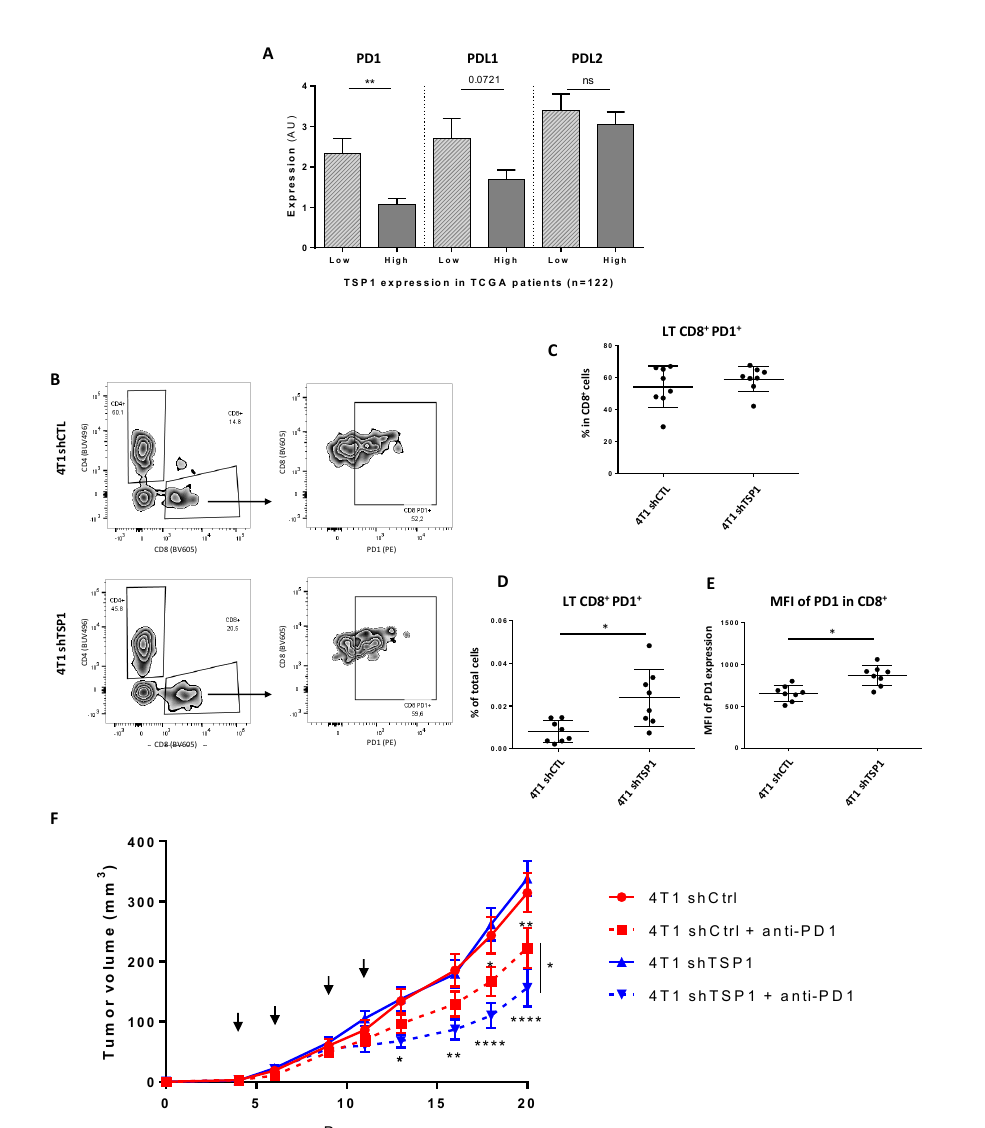
Figure 5. Impact of TSP1 expression on PD-1 expression and anti-PD-1 treatment in 4T1 mouse breast cancer model. ( A ) Analysis of PD-1, PD-L1 and PD-L2 expression in TCGA patients was performed depending on the median expression of TSP1 (**: p < 0.01). ( B – E ) At day 11, PD-1 expression on CD8+ TILs was quantified by flow cytometry on 4T1 shCTL and 4T1 shTSP1 tumors from Balb-c mice (*: p < 0.05) ( B ). Proportion of PD-1+ cells among CD8+ TILs ( C ) or total cells ( D ). Mean fluorescence intensity (MFI) of PD-1 expression on CD8+ TILs ( E ). ( F ): 1 × 10 5 4T1 shCTL or 4T1 shTSP1 breast carcinoma cells were orthotopically injected into the mammary fat pad of WT Balb/c mice. Mice received four injections of anti-PD-1 antibodies at days 4, 6, 9 and 11 (black arrows) at 10 mg/kg. Alternatively, mice were injected with isotype control. Tumor volumes were determined with a caliper at the indicated days. Data are means ± SEM obtained from 8 mice per group from one experiment. A two-way ANOVA with the Tukey multiple comparison test was used, and differences were statistically significant (*: p < 0.05; **: p < 0.01; ****: p < 0.0001).